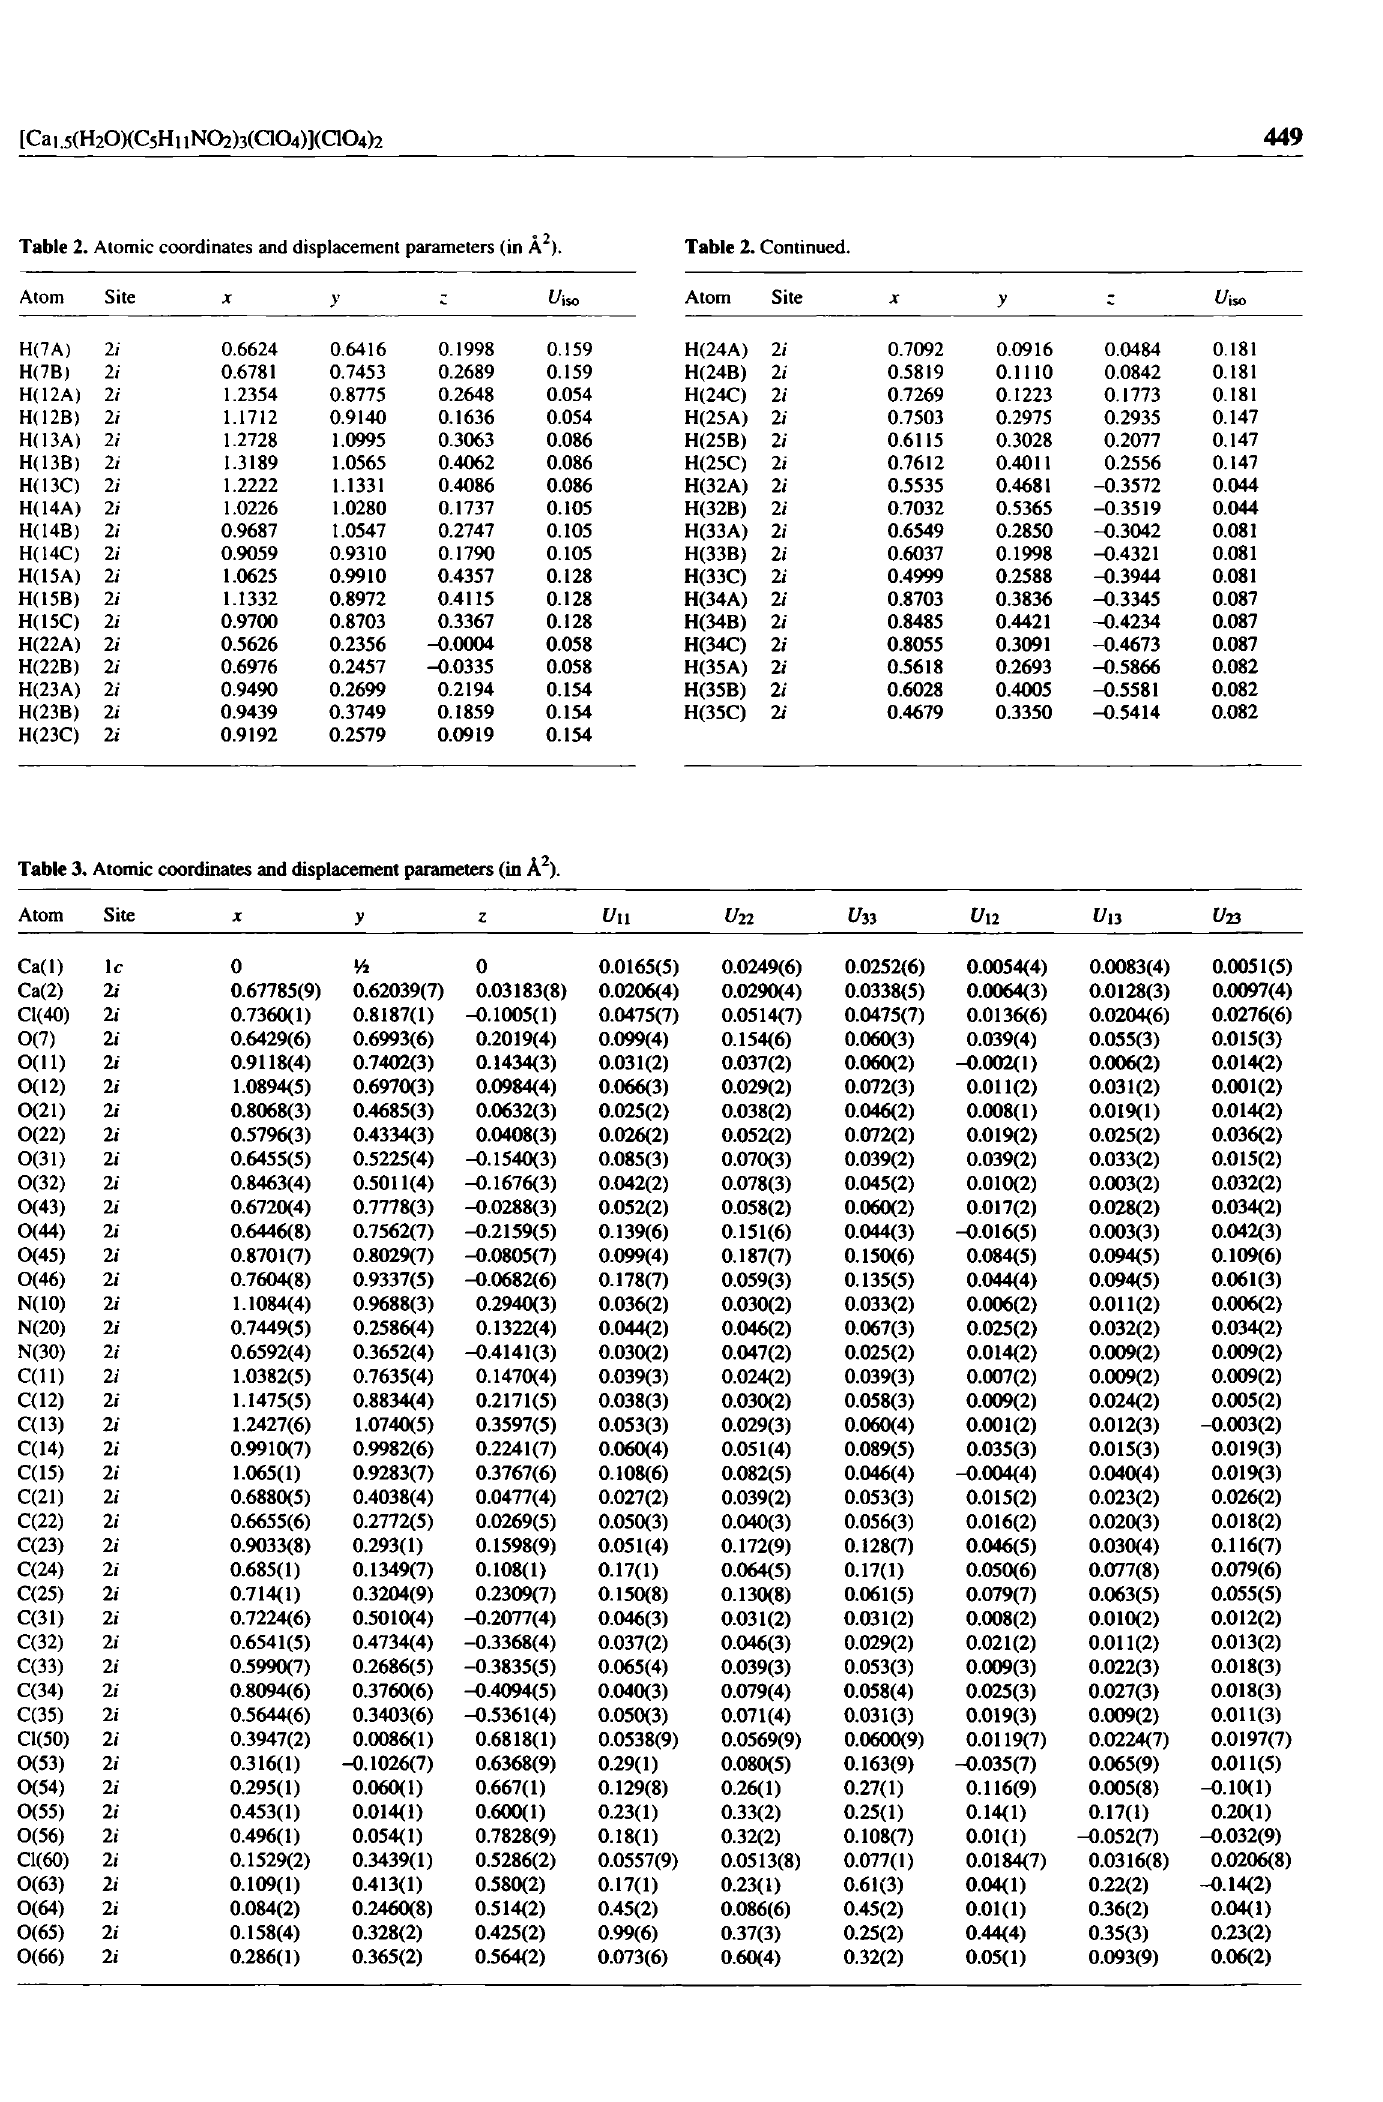
Table 3. Atomic coordinates and displacement parameters (in À 2